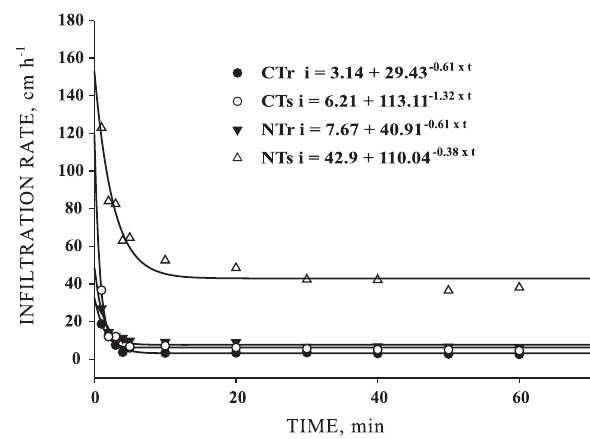
Figure 4. Water infiltration under conventional tillage (CT) and no-tillage (NT) with rotation (r) and succession (s) crop systems, in a Humic Cambisol, Lages, 2008. Means of four replications; n = 64